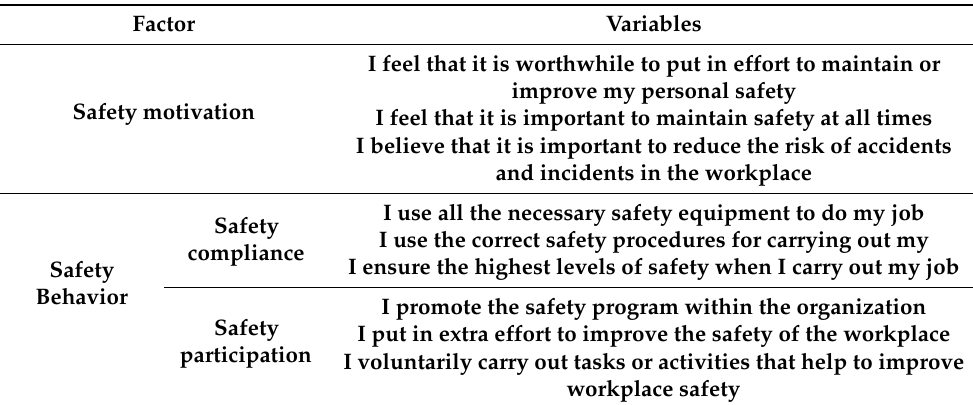
Table A2. Safety Behavior and Safety Motivation